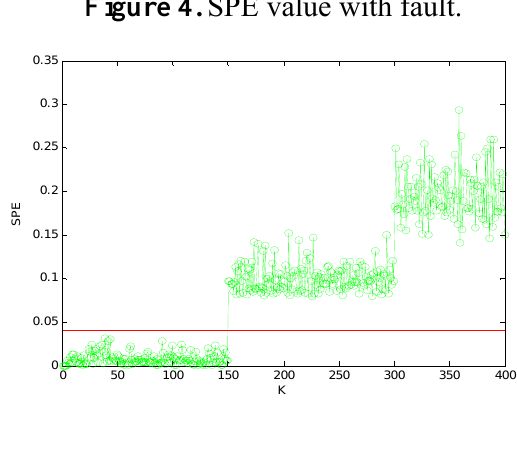
Figure 4. SPE value with fault.